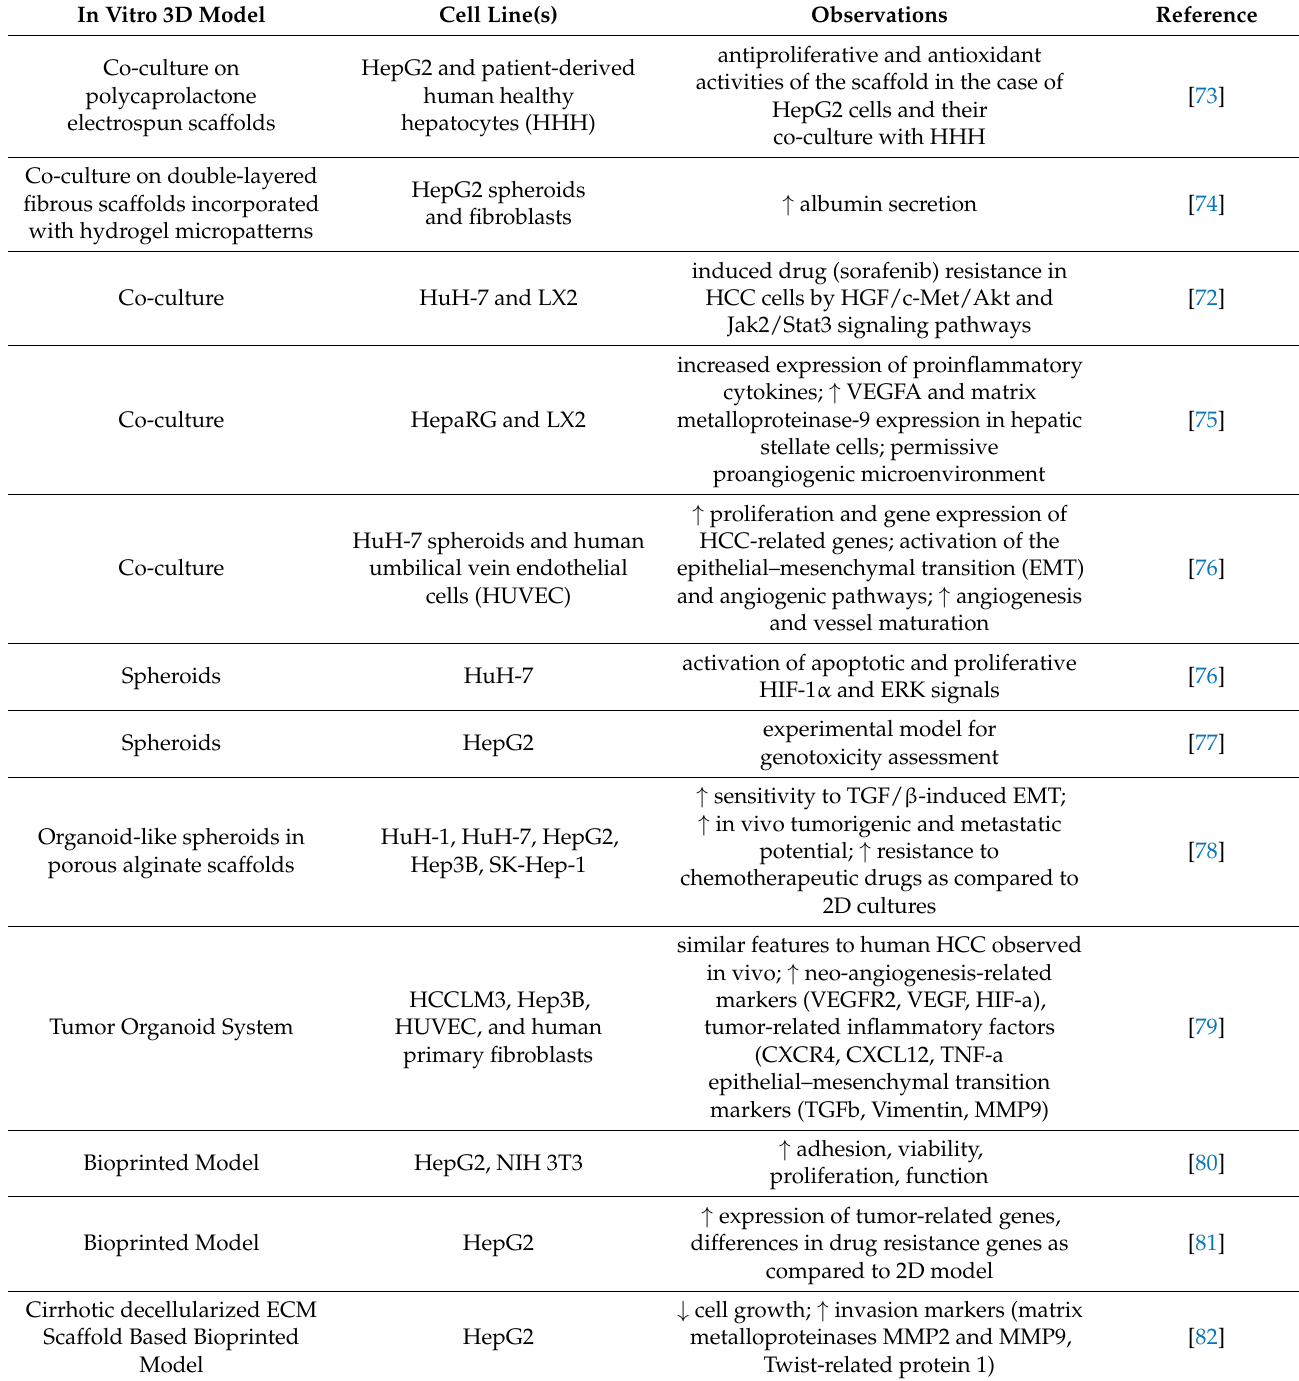
Table 2. Examples of in vitro 3D models of